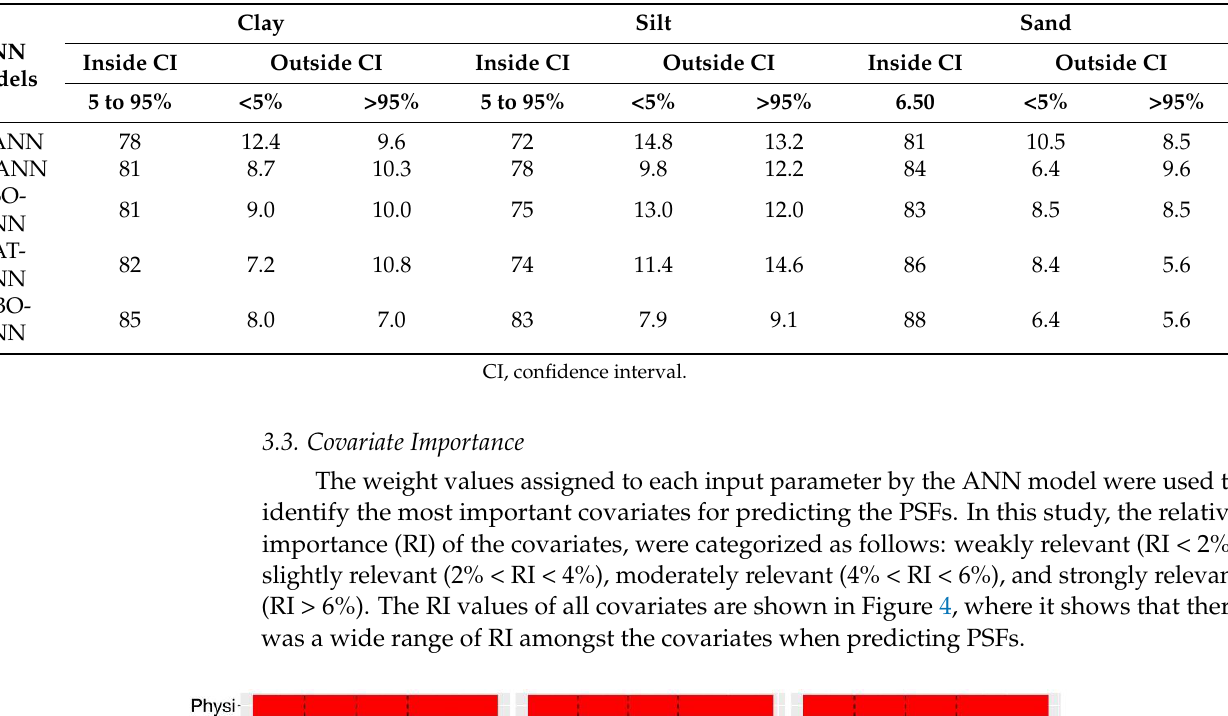
Table 4. The percentages (%) of three PSFs that fall within the 90% prediction intervals predicted by hybridized-ANN models.